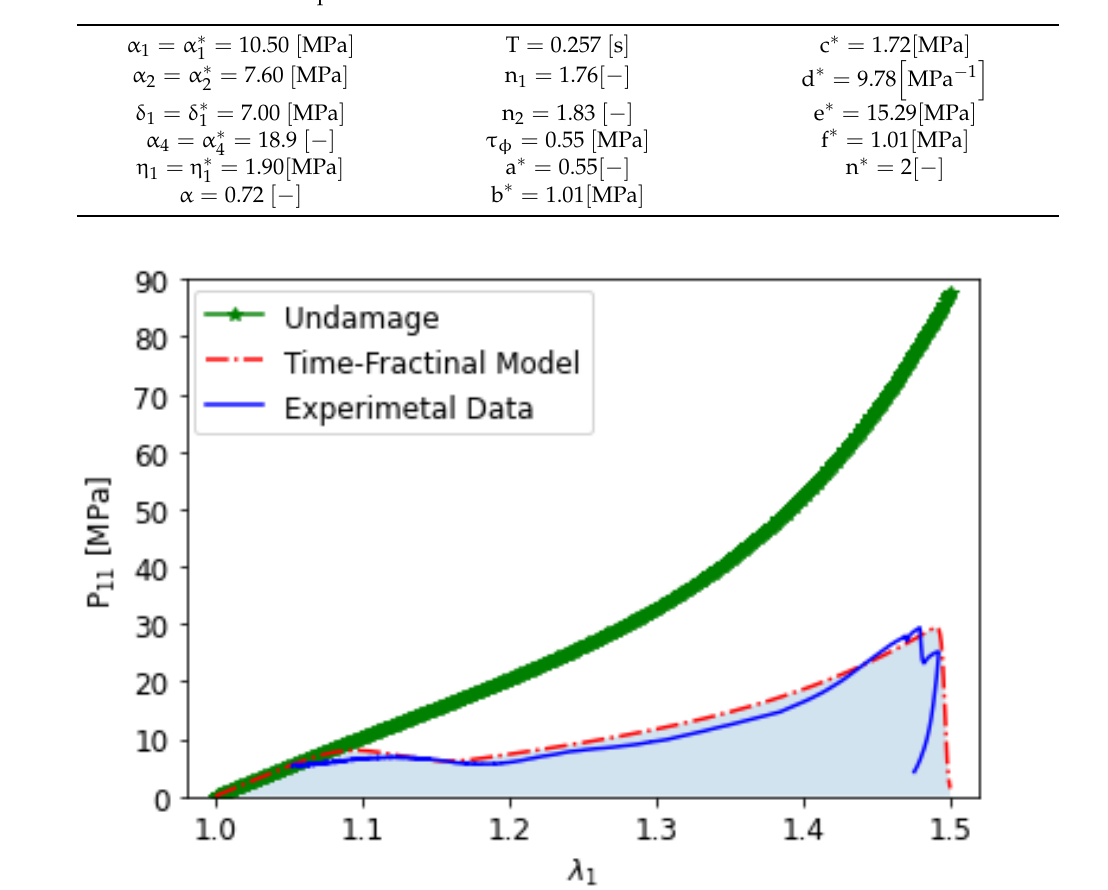
Table 1. HTFD material parameters for LIB.